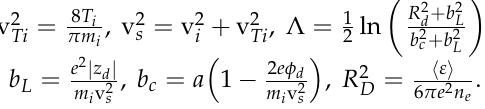
√ 8 T / π M ,, δ ≈ 1 is a coefficient depending on